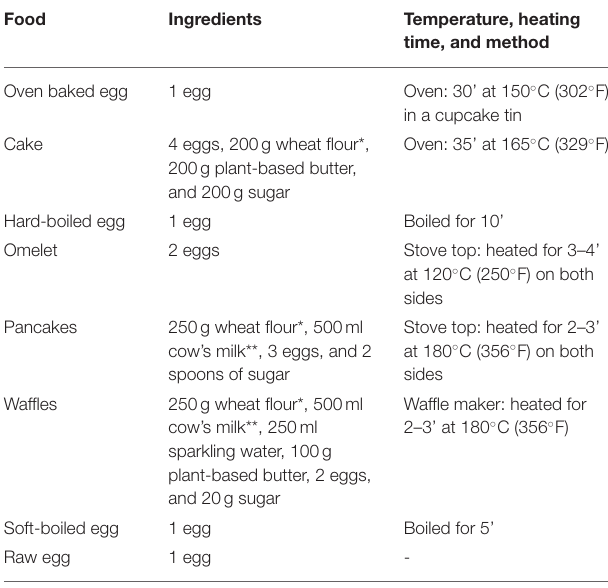
TABLE 1 | Preparation of the egg-containing products. Food